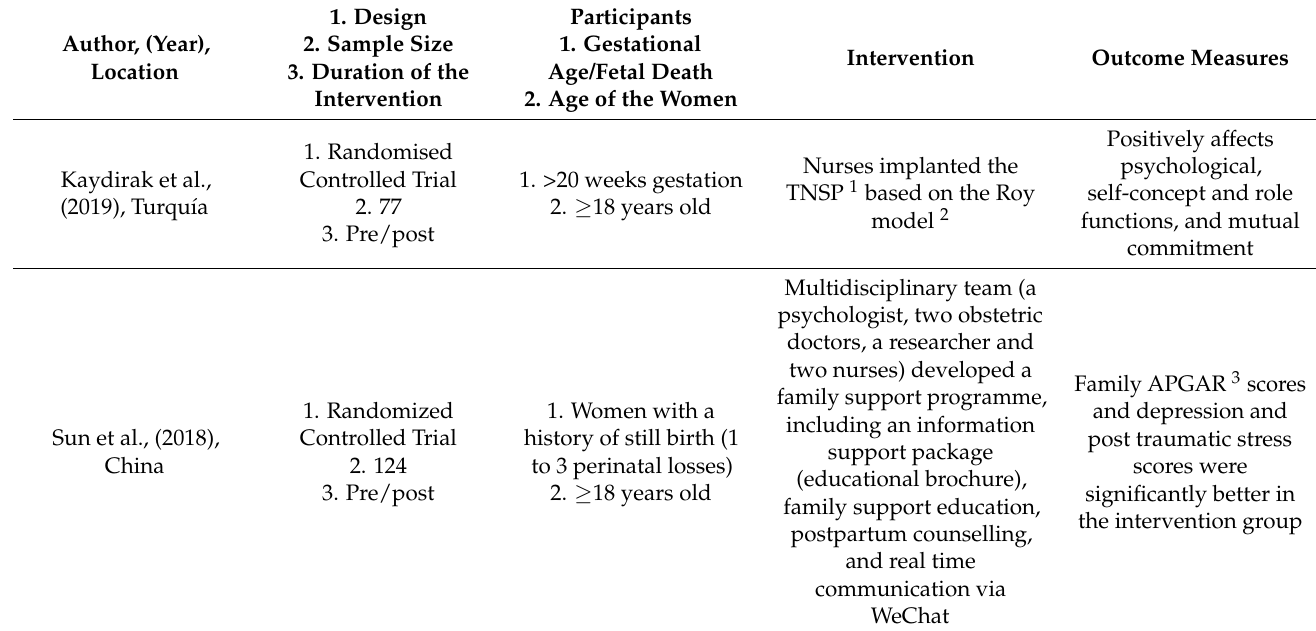
Table 3. Summary of studies included in the review.